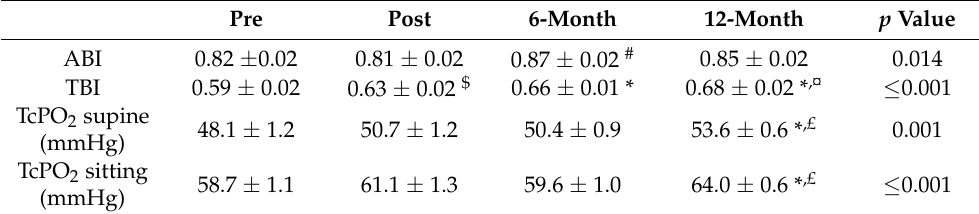
Table 5. Evolution of vascular parameters after supervised exercise training (SET).